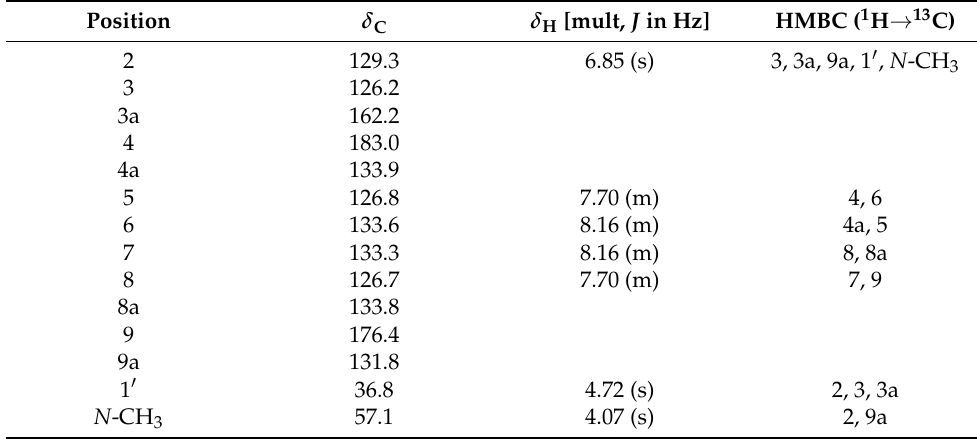
Table 2. 1 H (400 MHz) and 13 C (MHz) NMR spectroscopic data of 2 in CDCl 3 .